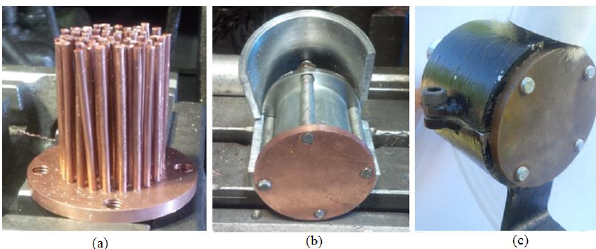
Figure 8. Solar receiver: (a) cooper fins, (b) internal structure, (c) external insulation.